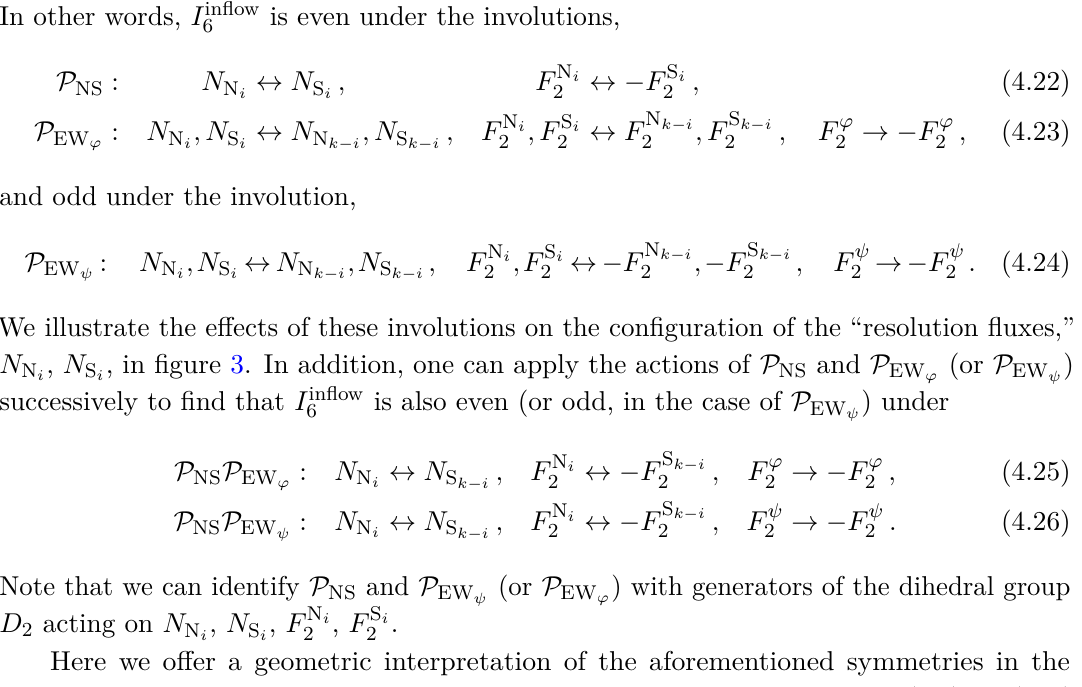
Figure 3 . Illustration of the effects of the involutions P NS ( left ), and P EW flux quanta N N , N S . For example, under the action of P NS , the roles of, say, N N i i interchanged, as indicated by one of the red double arrows in the diagram on the left. The two-form field strengths F N i , F S i follow a similar exchange 2 2